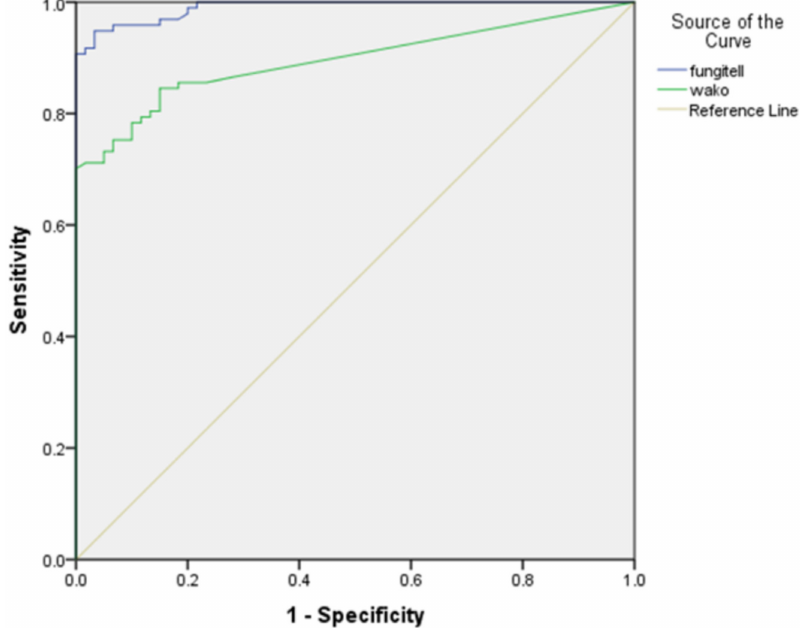
Figure 3. Receiver operating characteristics (ROC) curve showing the sensitivity and false positive rates (1–specificity) in detecting IFD (proven/probable) using the Fungitell BDG assay (blue) and Fujifilm Wako assay (green).